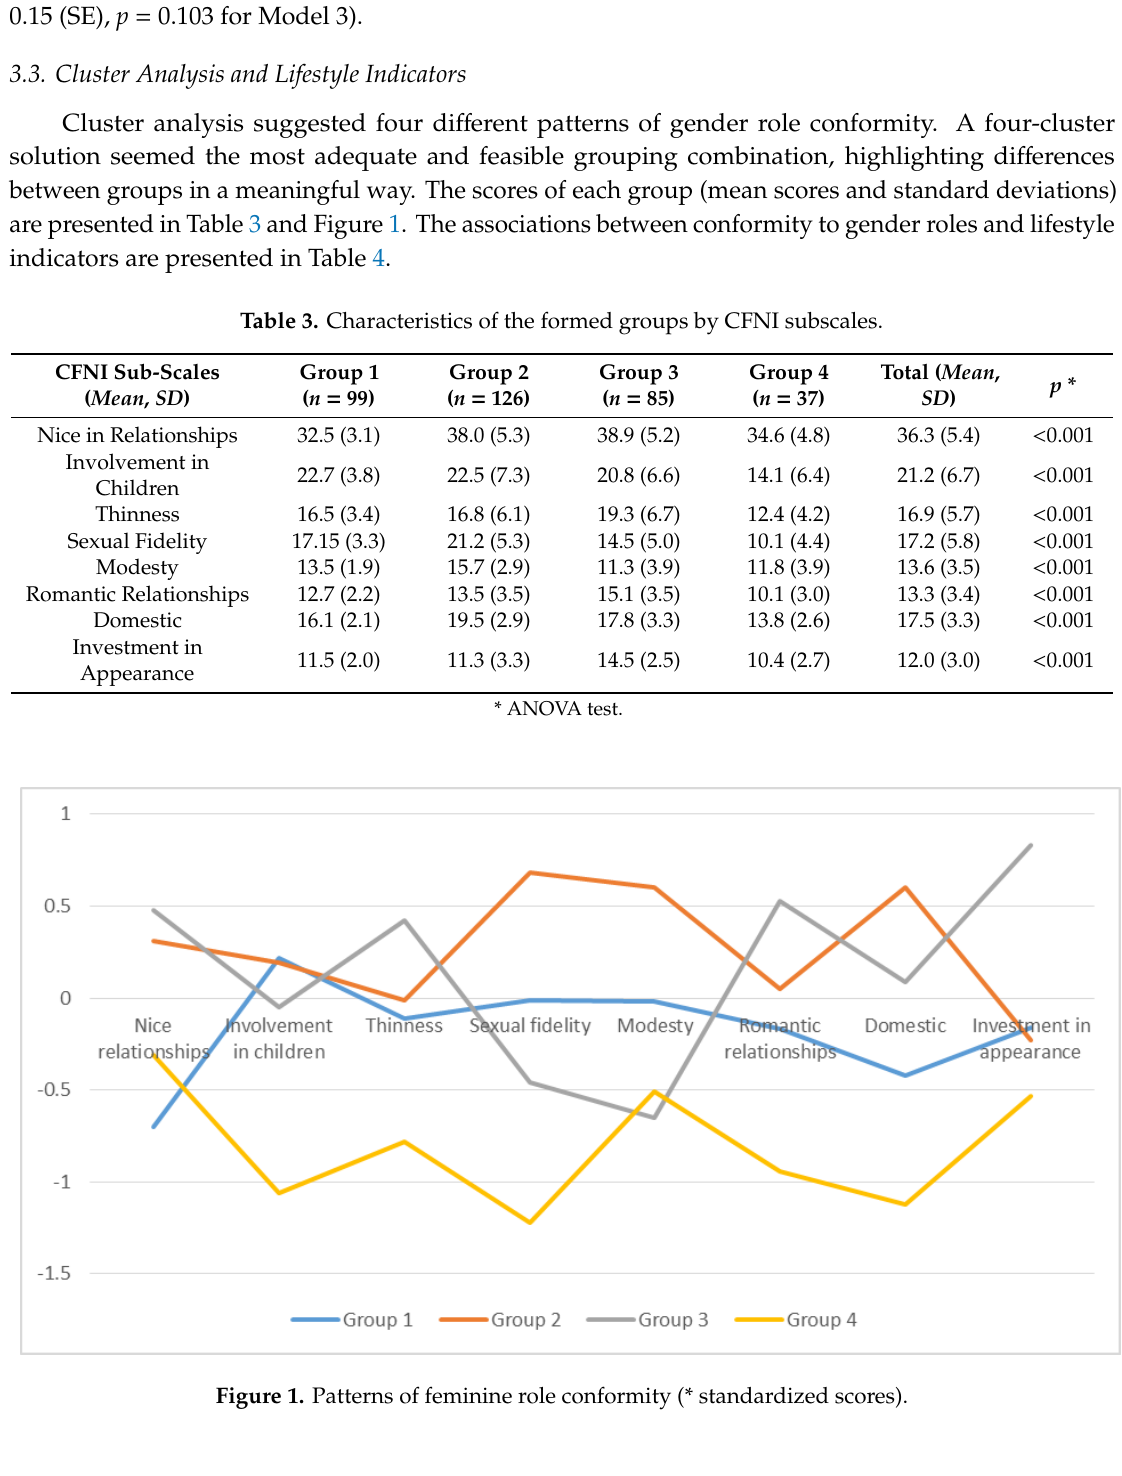
table: β = − 0.24, 0.15 (SE), p = 0.103 for Model 1; β = − 0.27, 0.14 (SE), p = 0.068 for Model 2; β = − 0.24, 0.15 (SE), p = 0.103 for Model 3).